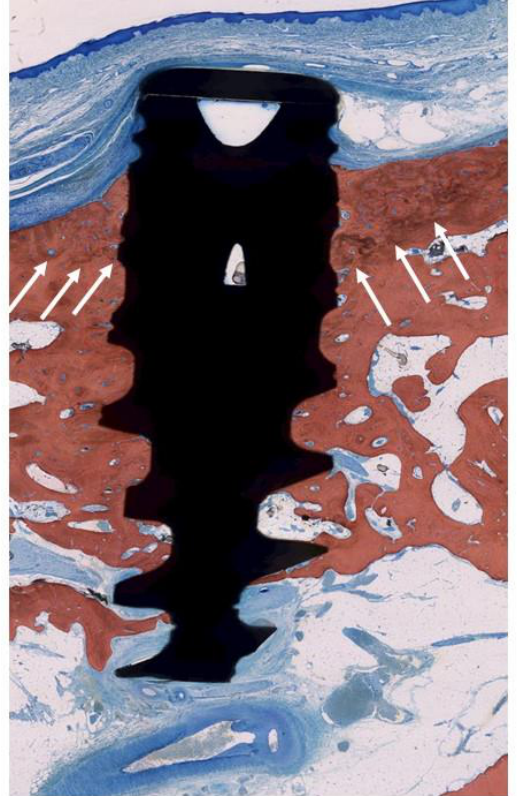
Figure 8. Histologic evaluation of healing after EC (TiUnite ® surface). The arrows indicate the bony crest before treatment. Bone-to-implant contact was achieved as more crestal than the neighboring bone level.